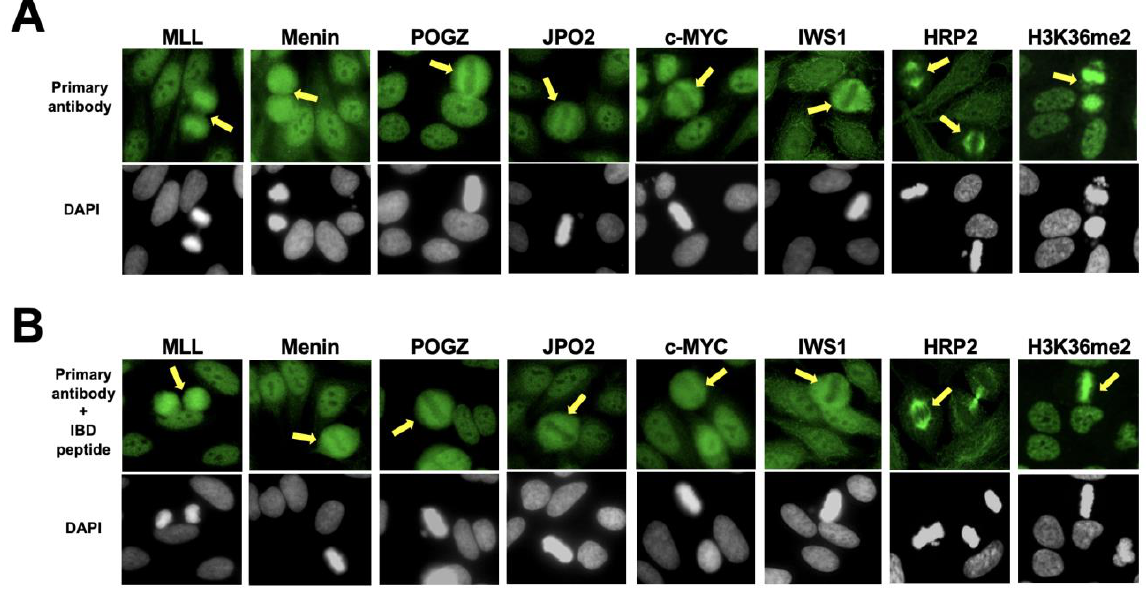
Figure 7. Immunofluorescence antibody patterns of selected DFS70/LEDGFp75 interacting partners in HEp-2 cells. ( A ) The IFA patterns of rabbit antibodies to the DFS70/LEDGFp75 interacting partners Menin, POGZ, JOP2, c-MYC, and IWS1 show nuclear dense fine speckles without strong and well-defined mitotic chromatin staining. HRP2 showed mitotic spindle staining without nuclear dense fine speckles. MLL and H3K36me2 showed both nuclear dense fine speckles and intense mitotic chromatin staining.Yellow arrows point to mitotic cells. ( B ) Pre-adsorption of the rabbit antibodies to DFS70/LEDGFp75 interacting partners with the IBD autoepitope peptide did not abolish their immunoreactivity, ruling out the possibility that these antibodies may be cross-reacting with the DFS70/LEDGFp75 IBD region. Fluorescent images were obtained using a Keyence Biorevo microscope. Chromatin staining with DAPI is presented in black and white for better